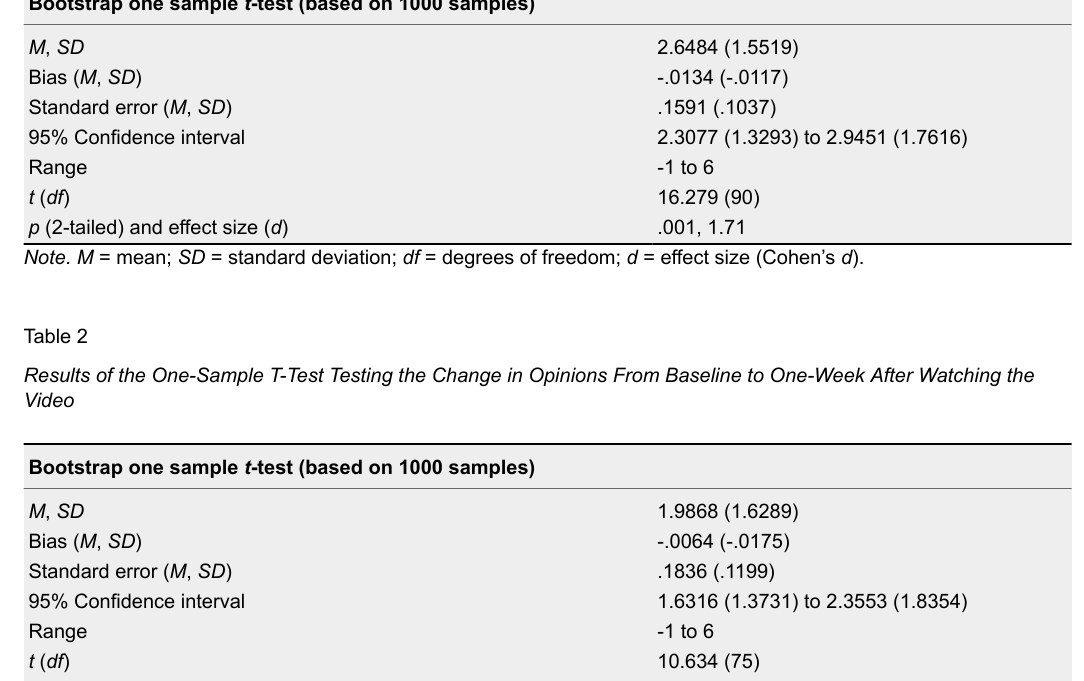
Results of the One-Sample T-Test Testing the Change in Opinions From Baseline to Immediately After Watching the Video Bootstrap one sample t -test (based on 1000 samples) M , SD 2.6484 (1.5519) Bias ( M , SD )